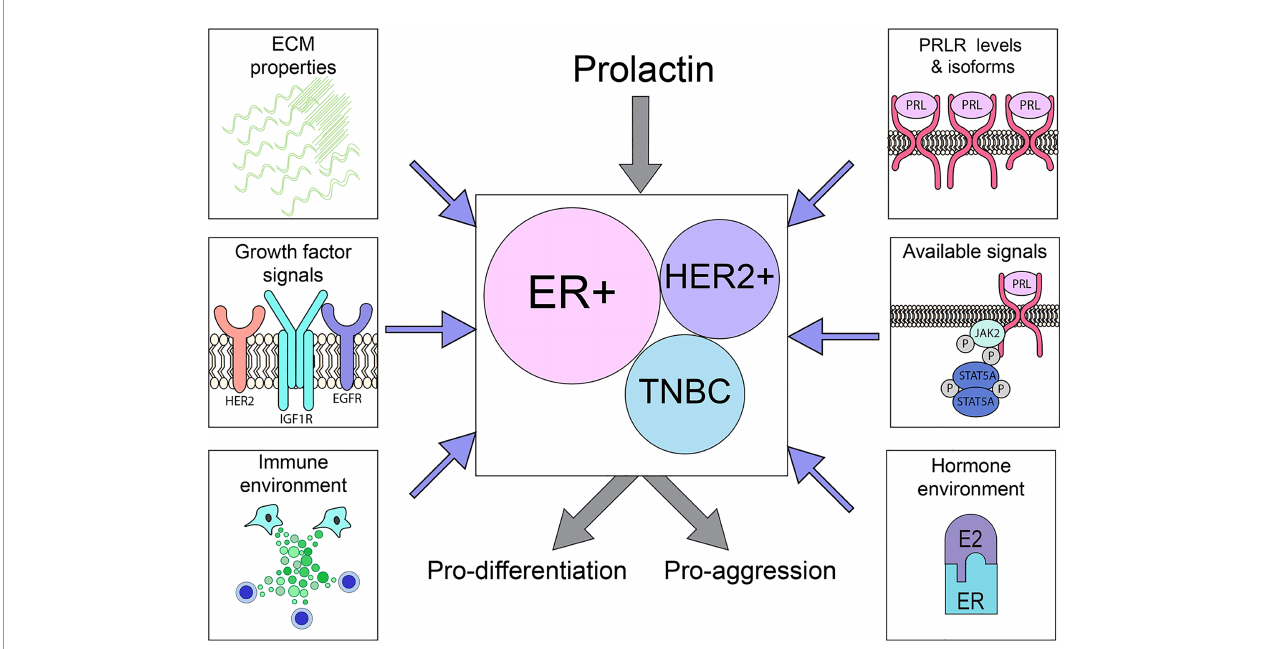
FIGURE 3 | PRLR is expressed on a substantial subset of breast cancers across the major subtypes. The outcome of PRL signals may vary considerably, driving either differentiation or aggression, depending on tumor cell intrinsic properties (PRLR expression, available downstream signaling cascades) as well as extrinsic factors (ECM characteristics, hormone/growth factor milieu), as illustrated above. See Section 3 for